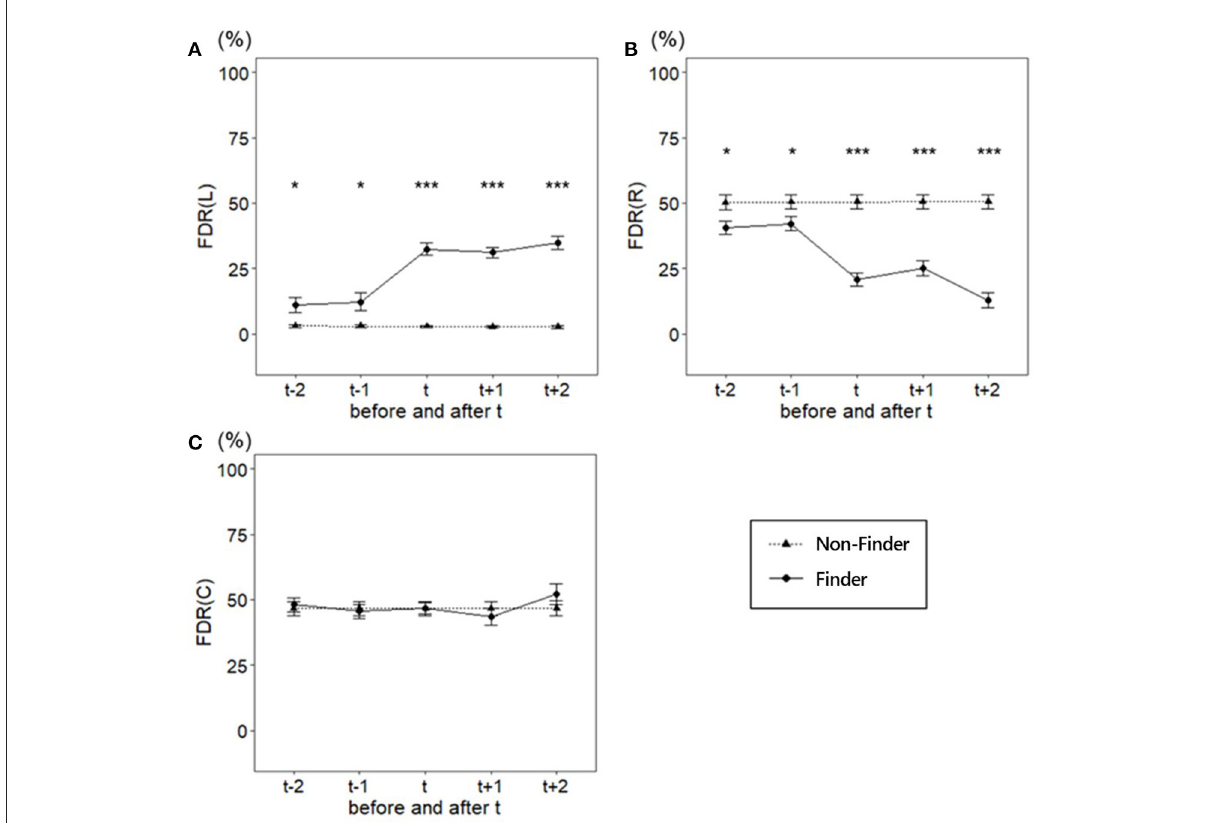
FIGURE6 Fixation Duration Rate during the two trials before and after the finding reporting trial t . (A) FDR in L area, (B) FDR of R area, (C) FDR of C area. Error bars are SE . *** p < 0.001, ** p < 0.01, * p <